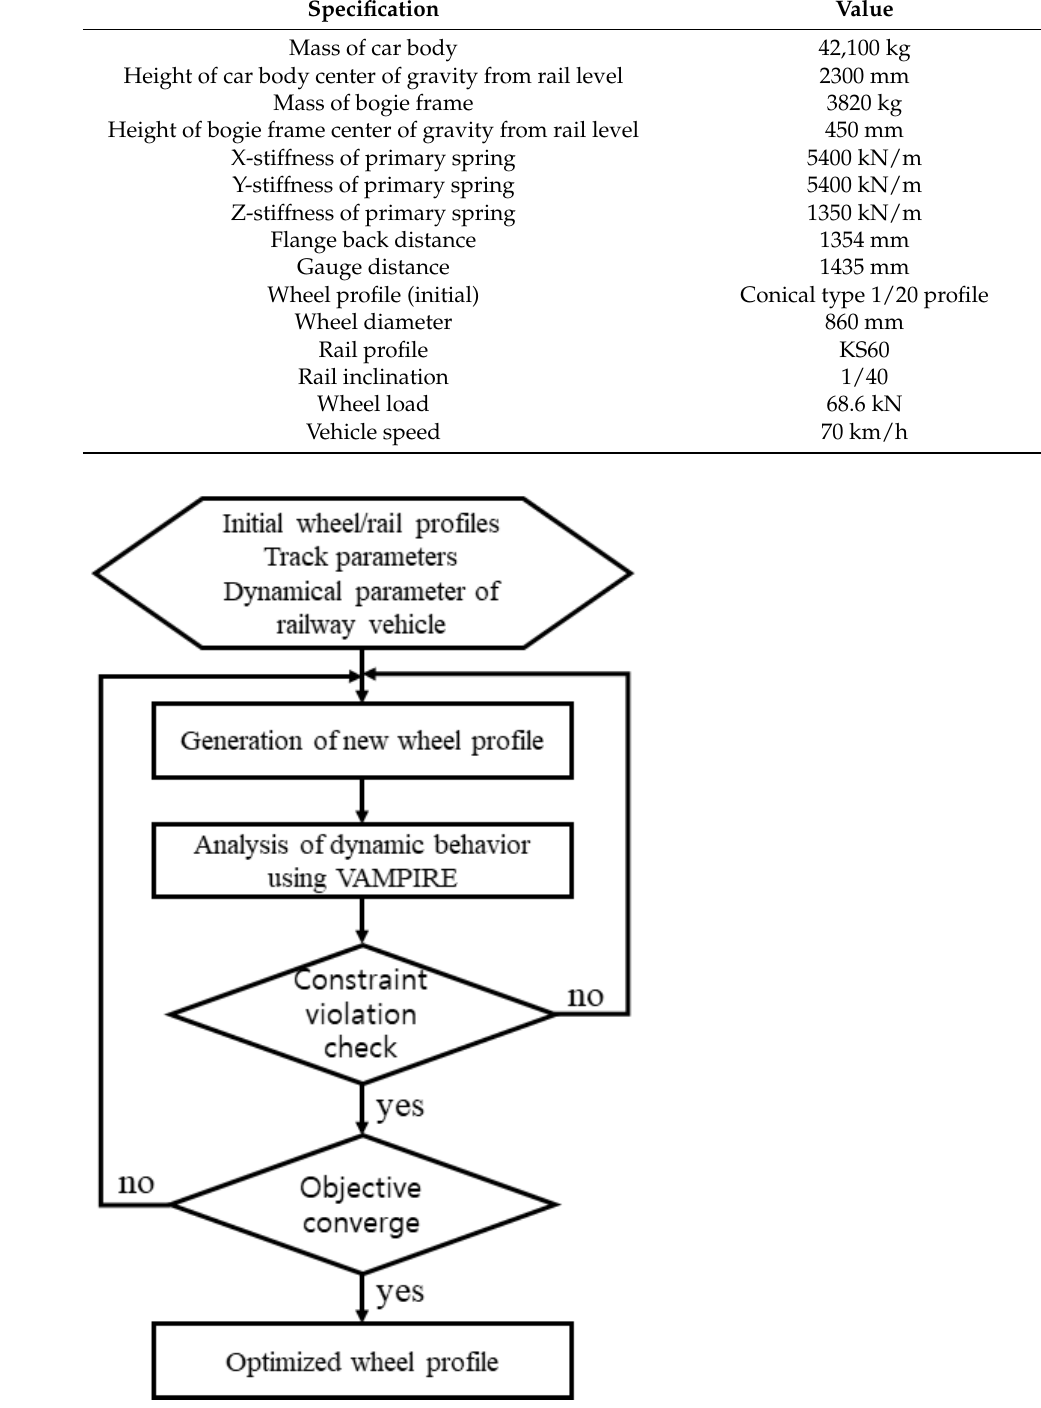
Figure 5. Procedure of wheel profile design